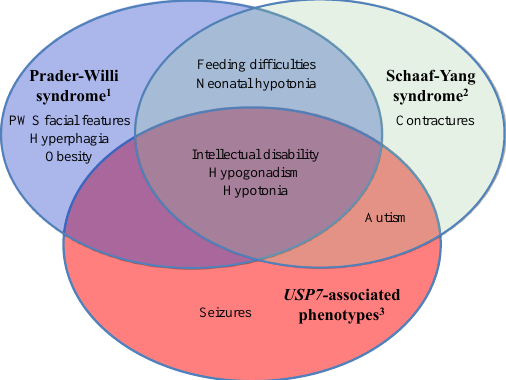
Figure 2. Prader-Willi syndrome, Schaaf-Yang syndrome, and USP7 -associated disorder represent a spectrum of neurodevelopmental disorders. Shared and distinct clinical features are illustrated. While none of the symptoms listed may be exclusive to any one condition, the figure attempts to highlight those features that have a high (>50%) prevalence in the respective disorders. 1 , disorder defined by